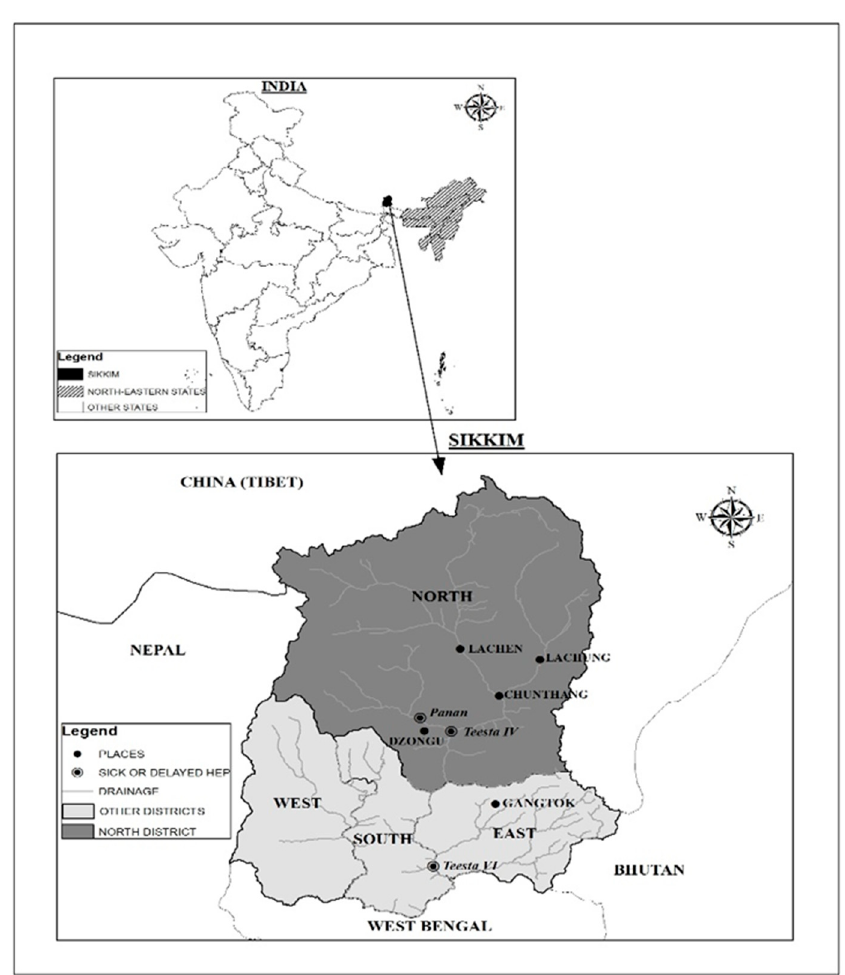
Figure 1. Delayed hydropower projects, fast tracked in Sikkim. Source: Own elaboration, adapted from GoS websites. Map not to scale.